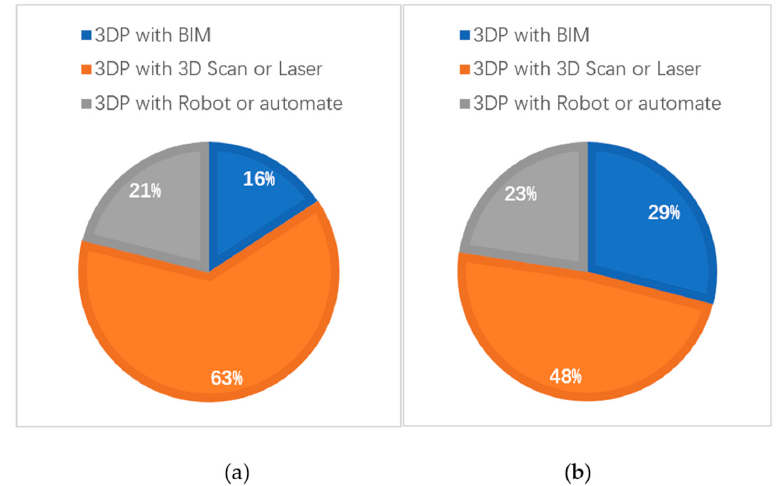
Figure 6. The distribution of papers in different topics: ( a ) English database Scopus; and ( b ) Chinese database CNKI.